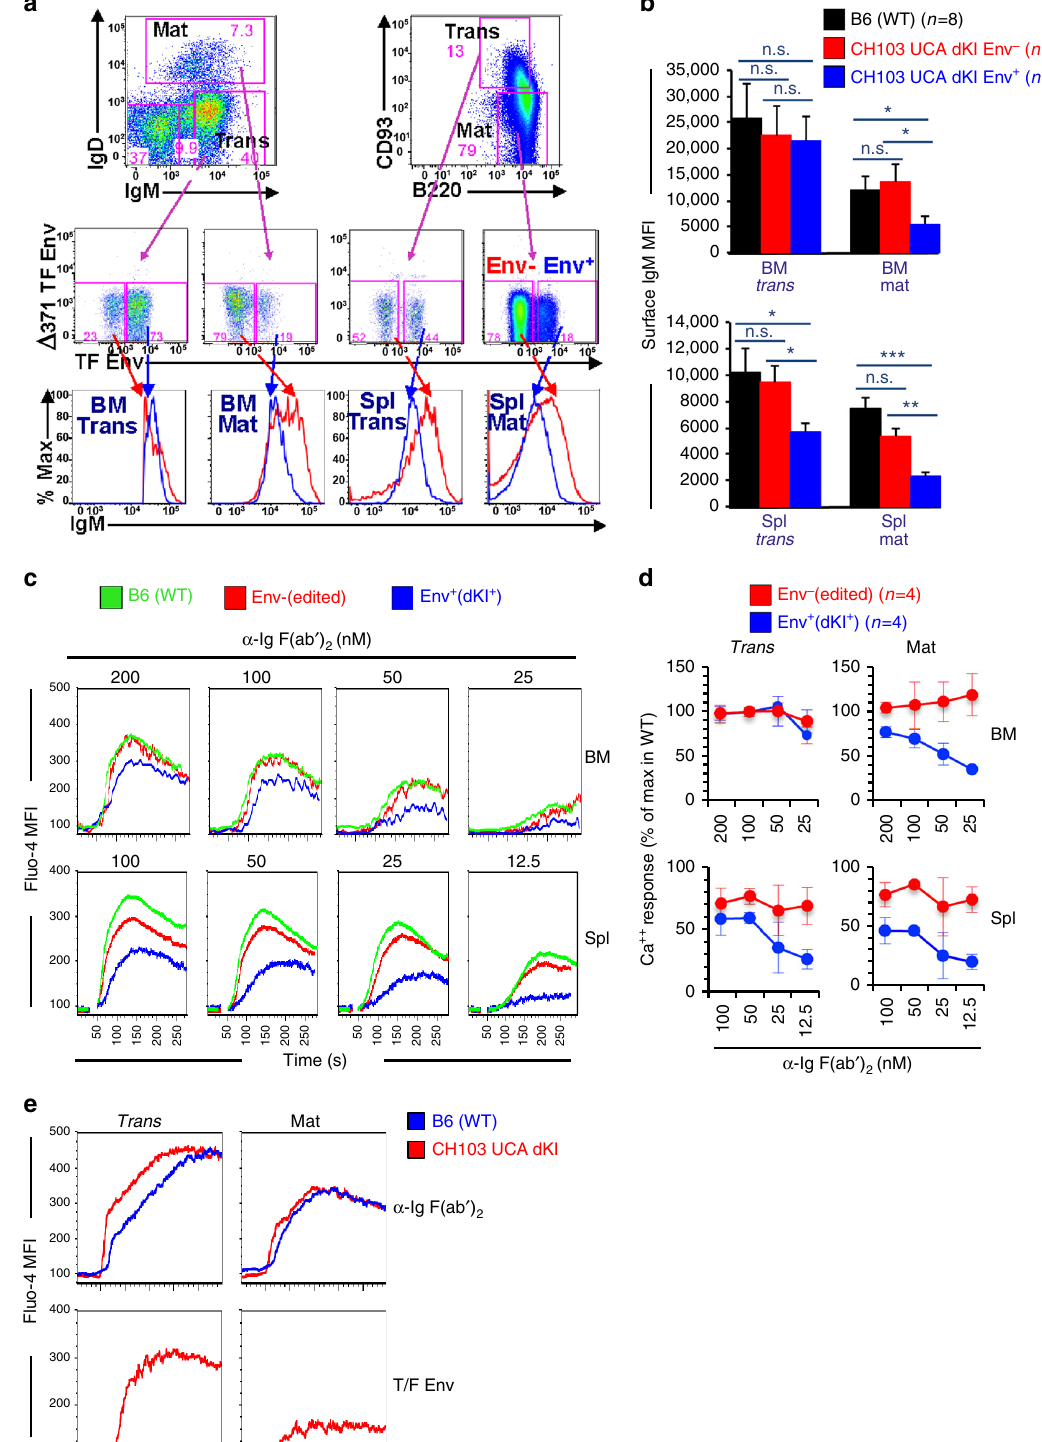
memory B cells from immunized mice had higher frequencies of KI HC-expressing clones that paired with KI LCs than did total IgG + memory B cells from control mice immunized with saline or GLA-SE alone (Fig. 7d, e). This enriched, immunization-induced, IgG + differentially sorted population (32% overall, compared to 4% in IgG + B cells from saline-immunized animals), con fi rms that some of the differentially binding memory population